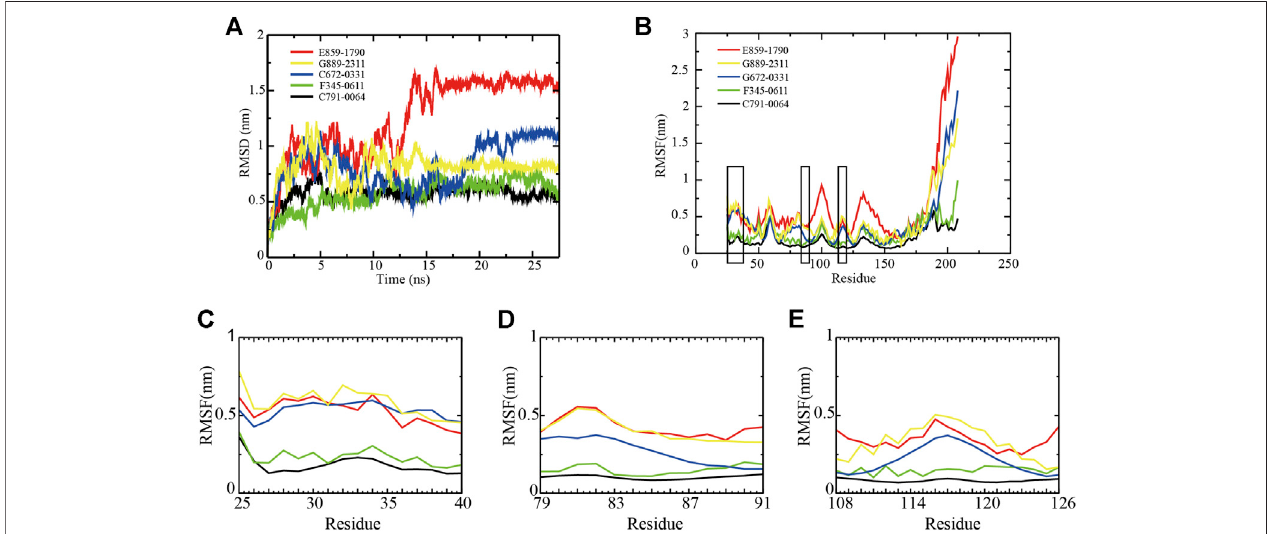
FIGURE 2 | Backbone RMSD and RMSF values of RAD52 – ligand complexes. (A) RMSD of the fi ve RAD52 – ligand complexes during a 27.5 ns simulation. (B) RMSFs of the amino acids within the RAD52 self-association domain during three equal portions of a 27.5 ns molecular dynamics simulation of RAD52 – ligand complexes. (C – E) presented the enlarged fl uctuation of three segments (Cys25-Gln40, Phe79-Gln91, and Cys108-Tyr126) containing the key amino acids in the RAD52 self-association binding sites involved in RAD52 – ligand